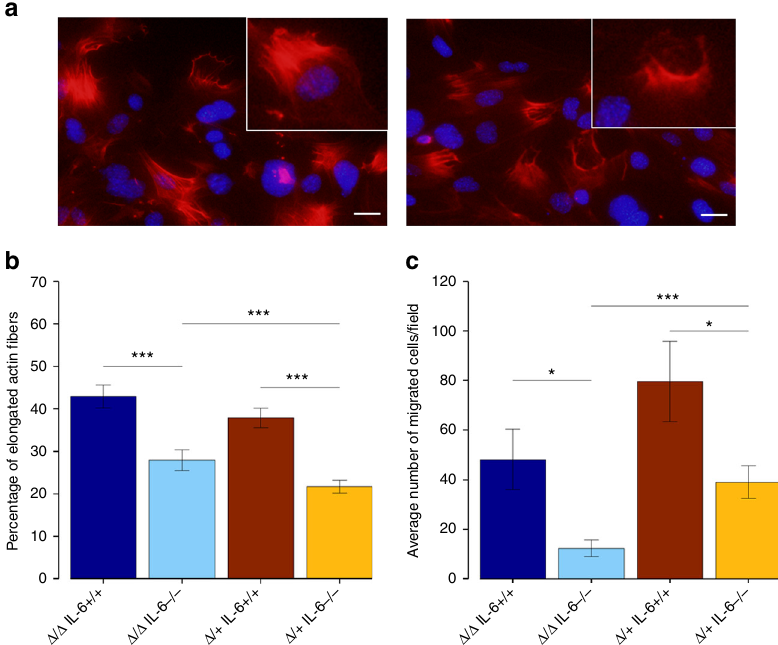
Fig. 4 Loss of IL-6 reduces cell migration and actin polarisation in Δ 122p53-expressing MEFs. a Examples of phalloidin staining illustrating actin fi bre polarisation in Δ 122/ Δ 122 IL-6+/+ MEFs (images taken at ×400 magni fi cation). Scale bar = 20 μ m. Migrating cells were stained with Hoescht (blue) and Phalloidin (red). b The average % of phalloidin-stained cells with elongated actin fi bres was quantitated. This was done with ‘ blinding ’ by two independent researchers. c The average number of migrated MEFs/ fi eld 4 h after seeding into Transwell inserts. The bars represent the mean and error bars represent ± s.e.m. of 15 independent fi elds. A p -value was obtained after performing a heteroscedastic, two-tailed unpaired t -test between different groups. p < 0.05 was considered signi fi cant. * p < 0.05 and *** p < 0.0005 are designated,